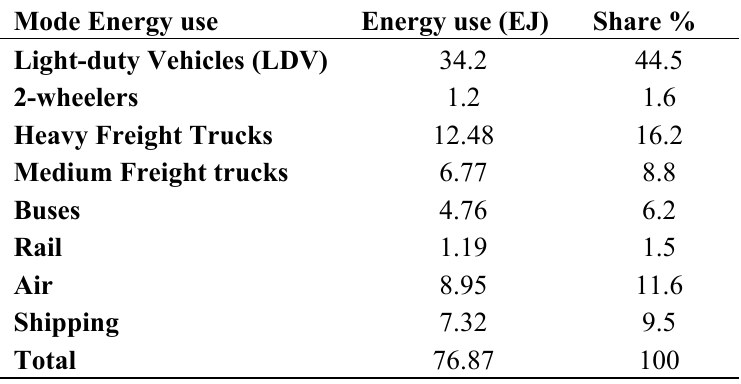
Table 1. World transport energy use in 2000, by mode.